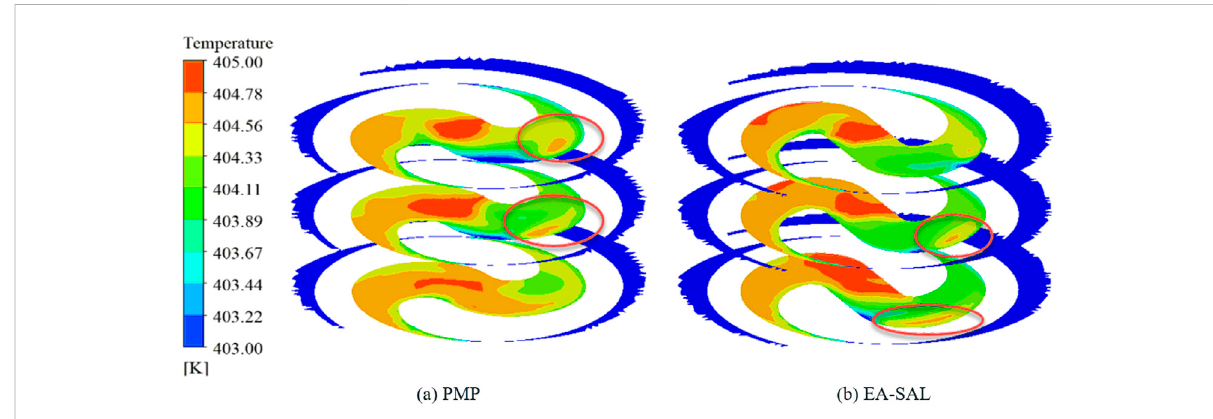
FIGURE 8 Temperature distribution in the center of tooth head at 240 ° angle.